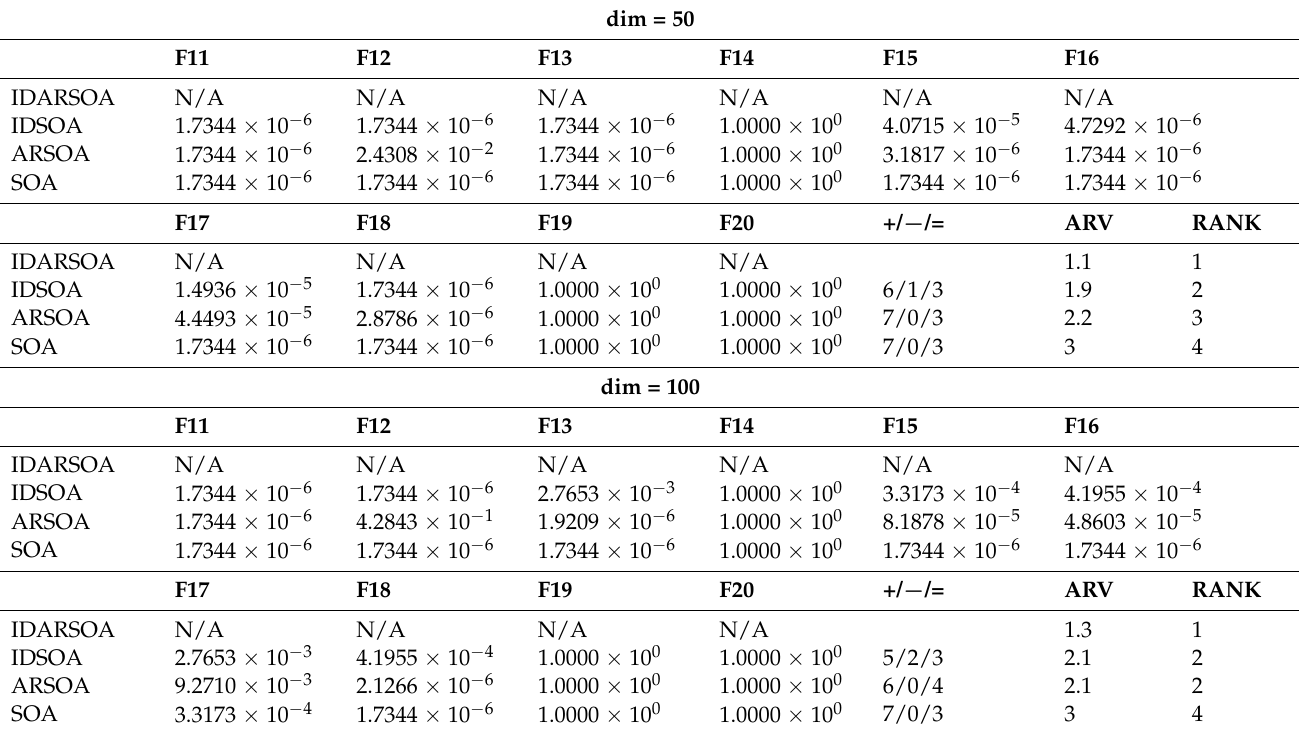
Table 6. Comparison of Wilcoxon signed rank test results of different SOAs in high dimension. dim =